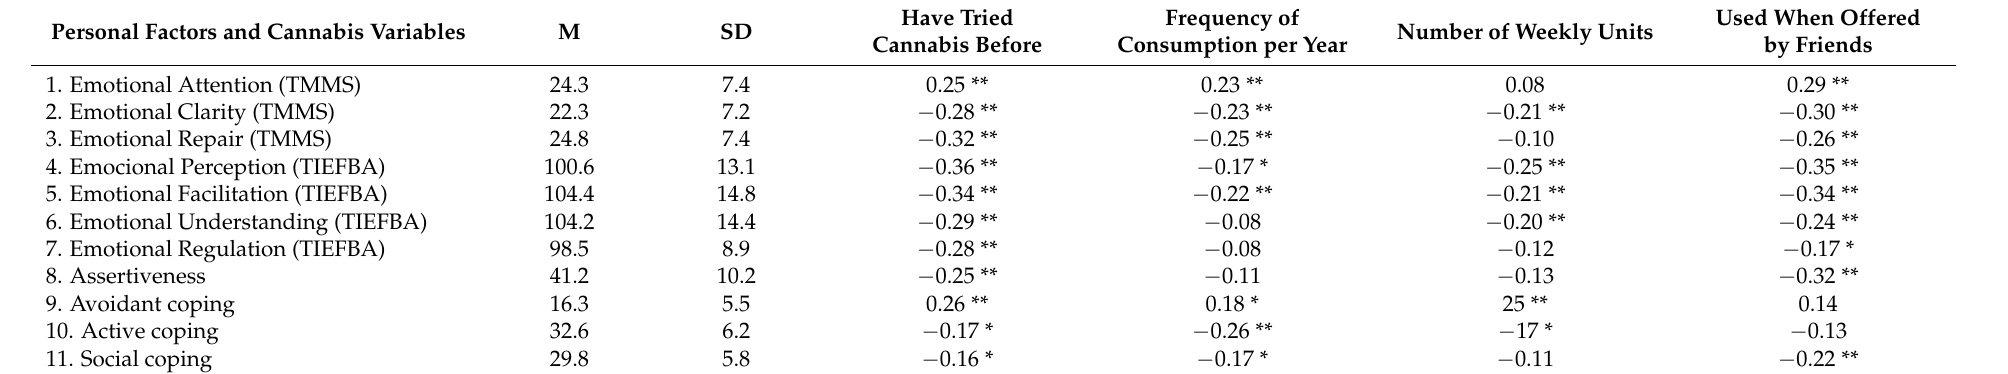
Table 2. Descriptive and biserial point correlation analysis of personal factors with respect to cannabis use